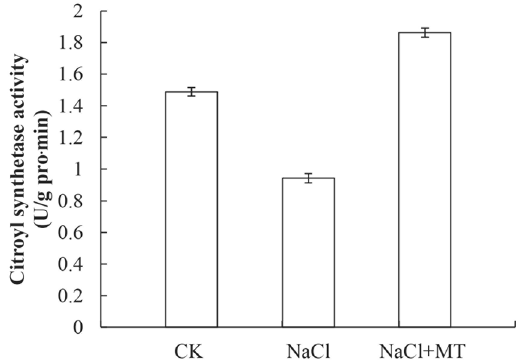
Figure 7. Effects of 1 μ M melatonin on citroyl synthetase activity during germination of cucumber seeds under salt stress. Vertical bars represent ± S.E (n =